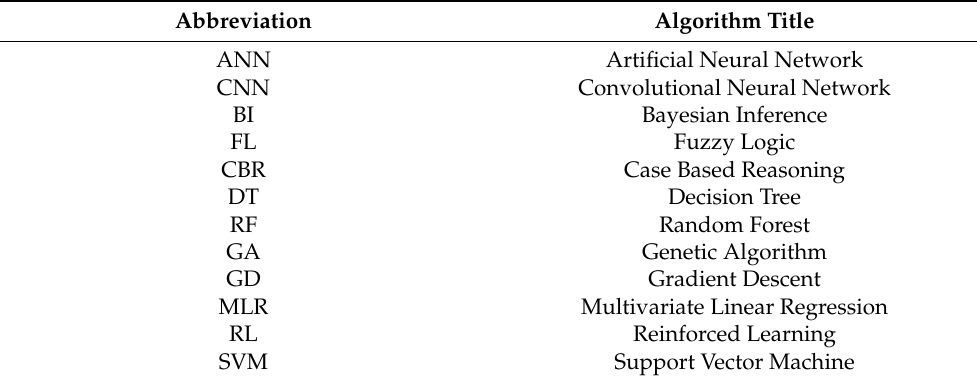
Table 3. A table expressing the various artificial intelligence algorithms from the study of the literature with the associated